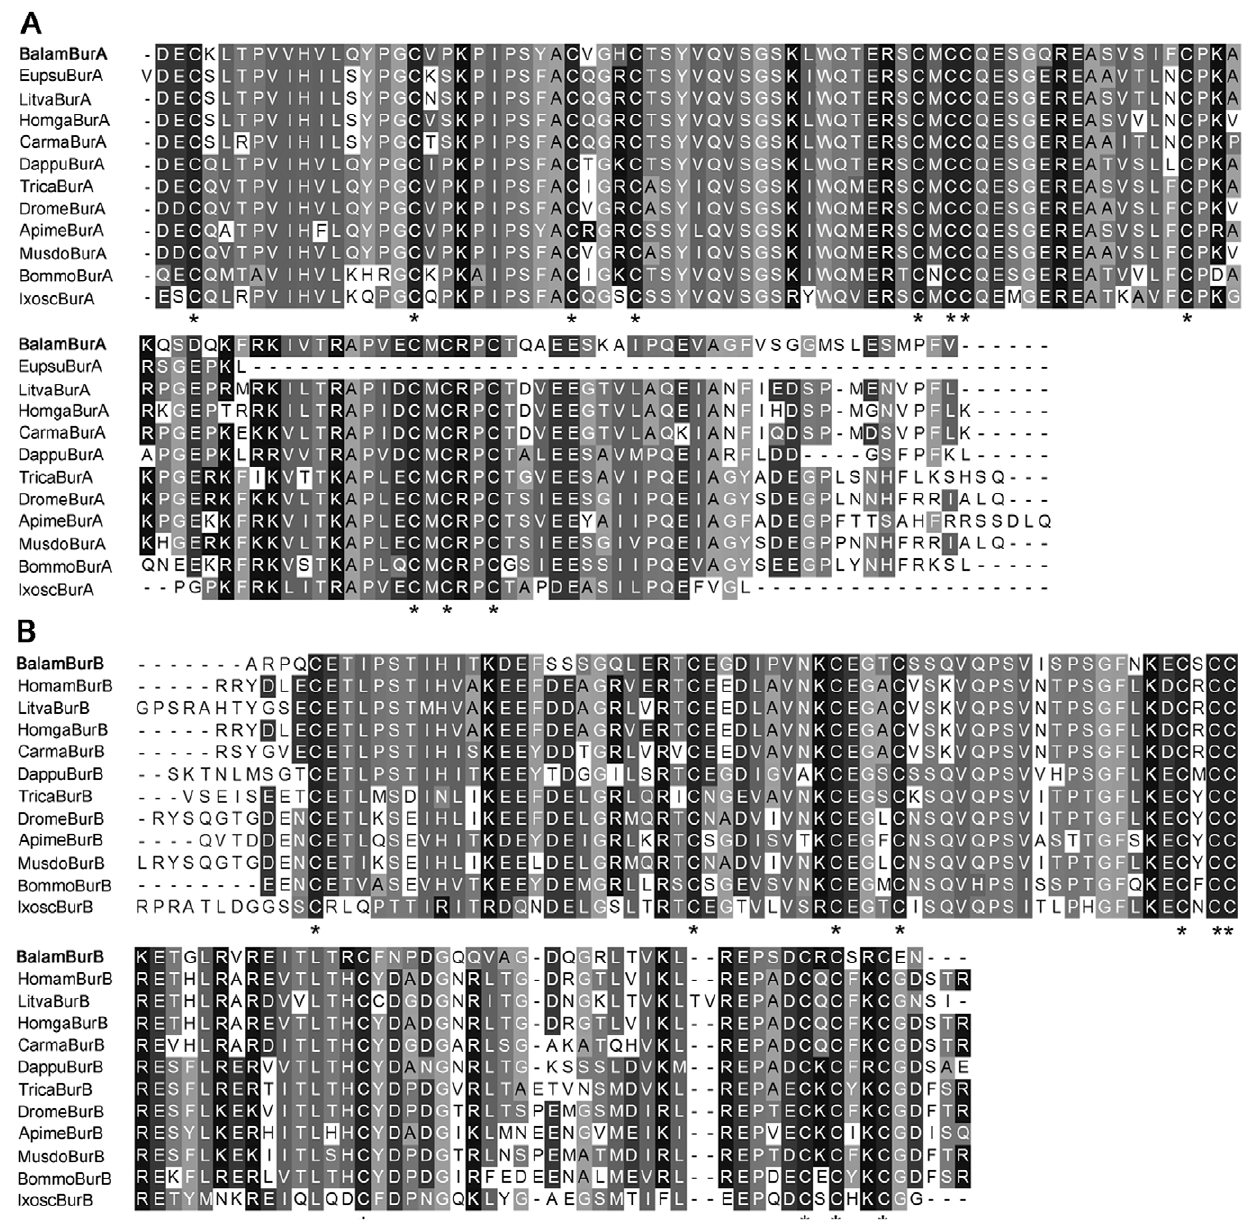
Figure 8. Sequence alignment of barnacle bursicon peptides. (A) Alignment of bursicon a subunit. Sequences are from: euphausiacean Euphausia superba [22]; decapods Litopenaeus vannamei [22], Homarus gammarus ADI86242.1 and Carcinus maenas EU139428; branchiopod Daphnia pulex [38]; insects Tribolium castaneum DQ138190, Drosophila melanogaster NM_142726, Apis mellifera NM_001098234, Musca domestica EF424614 and Bombyx mori NM_001098375; chelicerate Ixodes scapularis XM_002407468. (B) Alignment of bursicon b subunit. Sequences are from: decapods Homarus americanus [22], Homarus gammarus ADI86243.1, Litopenaeus vannamei [22] and Carcinus maenas EU139429; branchiopod Daphnia pulex [38]; insects Tribolium castaneum DQ156997, Drosophila melanogaster NM_135868, Apis mellifera NM_001040262, Musca domestica EF424613 and Bombyx mori NM_001043824; chelicerate Ixodes scapularis XM_002407469. Asterisk ‘‘*’’ mark the conserved cysteine that will form dimers.